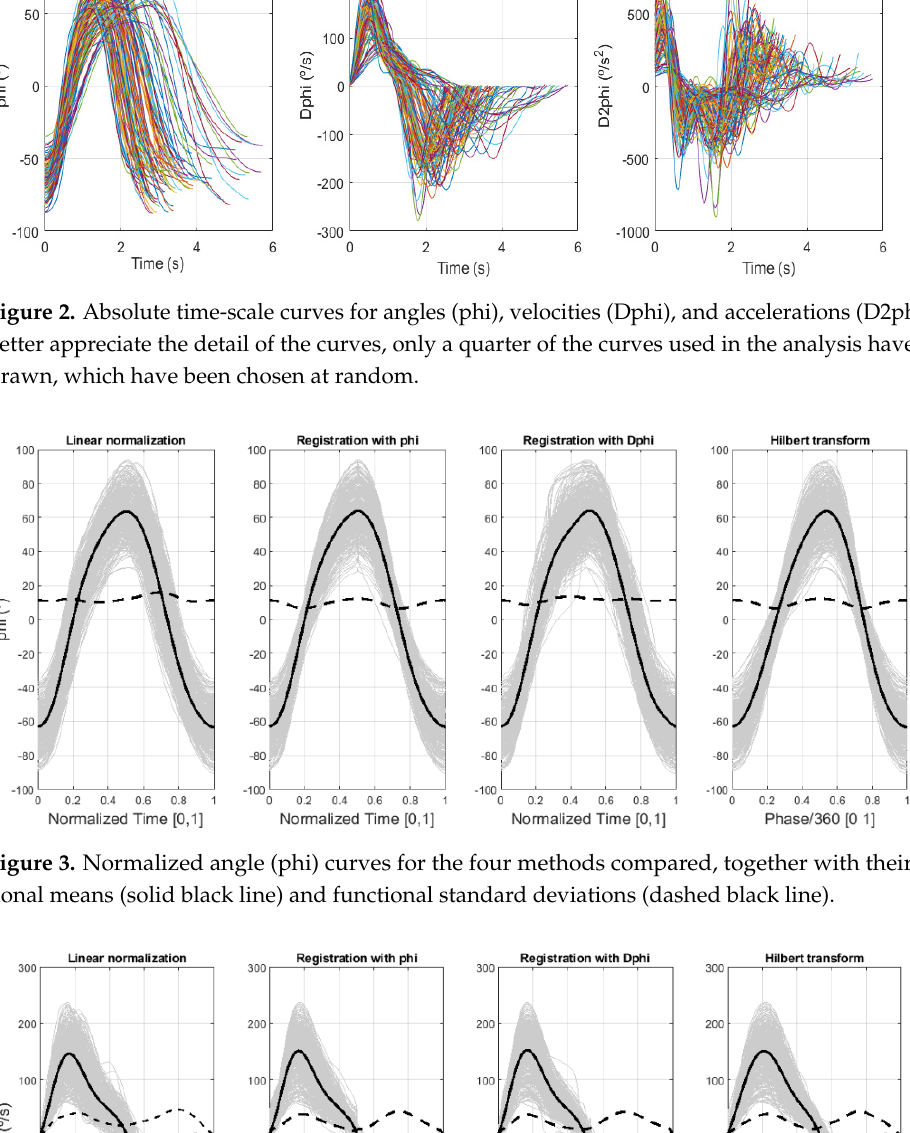
Figure 3. Normalized angle (phi) curves for the four methods compared, together with their functional means (solid black line) and functional standard deviations (dashed black line).